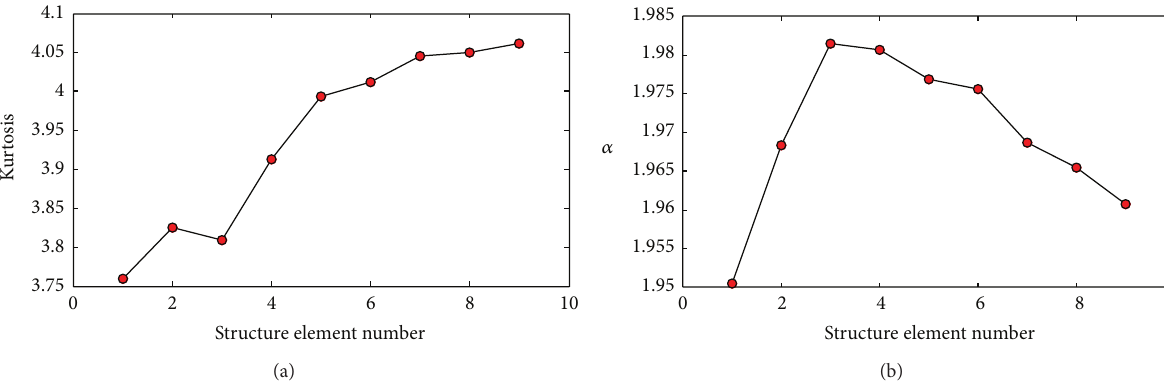
Figure 13: (a) Kurtosis value versus length of SE for 16,384 samples; (b) 𝛼 value versus length of SE for 16,384 samples.